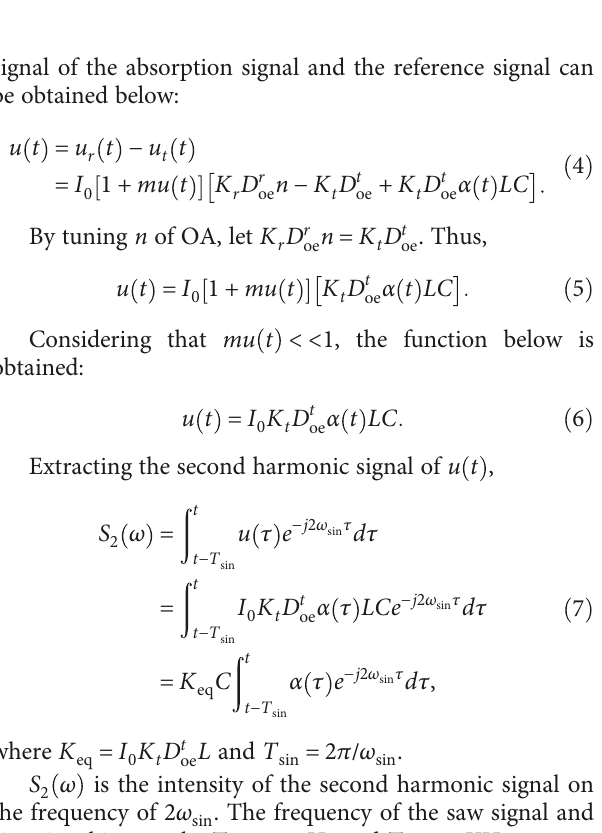
Figure 2: Schematic of the WMS-based CO detection system using a DFB laser at